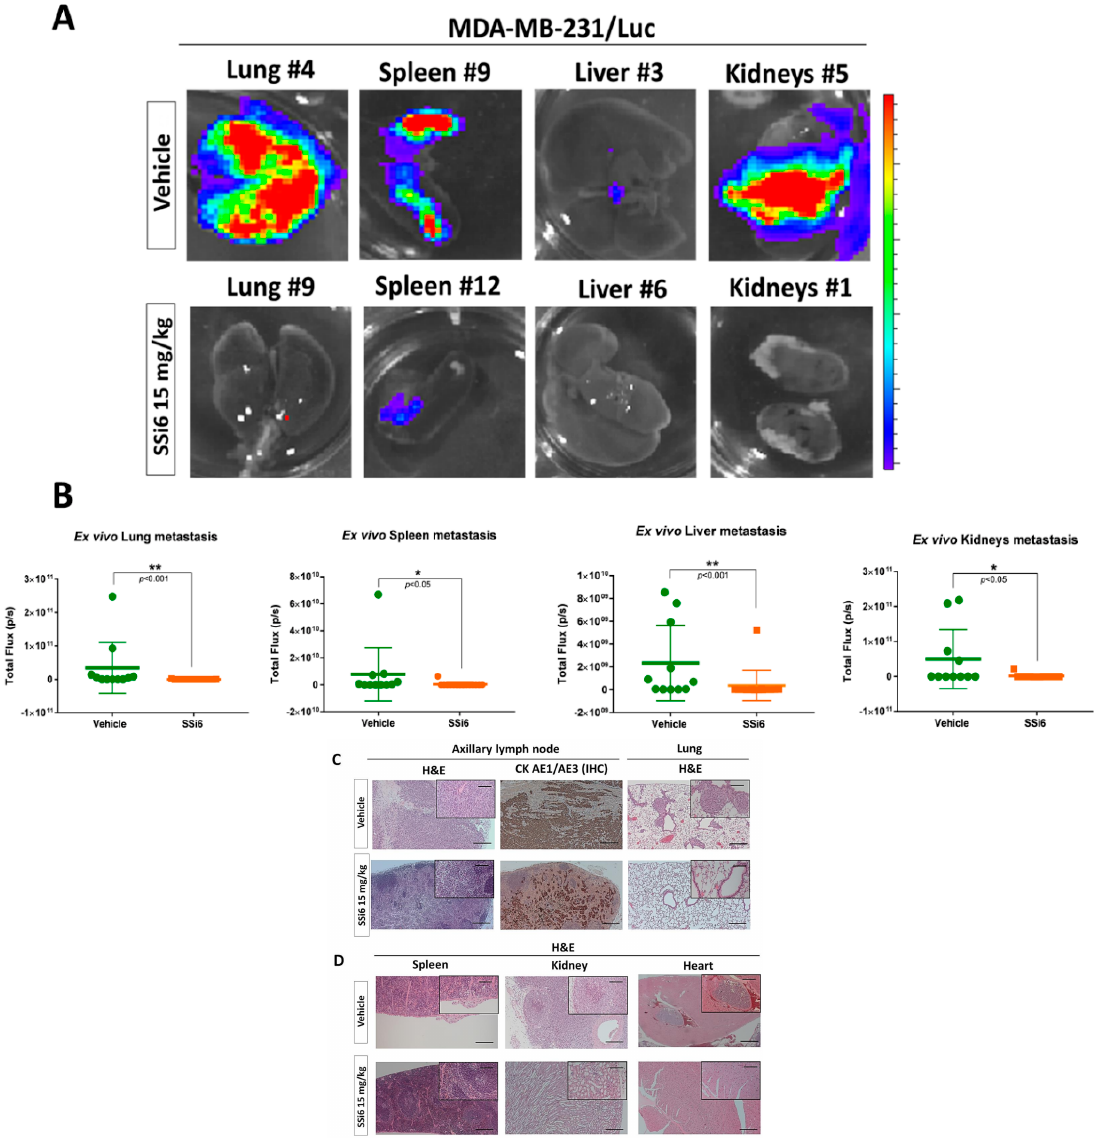
Figure 6. SSi6 interferes with multi-organ metastases and block the advancement of MDA-MB-231/Luc cells from lymph nodes to the lungs in a xenograft model with resection of the primary tumor. ( A ) Ex vivo bioluminescence images of the organs of the vehicle group (n = 11) and SSi6 15 mg/kg (n = 15). ( B ) Ex vivo graphs of the lung, spleen, liver, and kidneys, respectively. p -values were generated by Student’s t -tests (* p < 0.05, ** p < 0.001). ( C ) Micrograph of H&E staining and anti-human pan-cytokeratin IHC of harvested tissue to confirm the presence of breast cancer cell in the axillary lymph node. ( D ) Representative images of H&E stains showing metastatic nodules in the spleen, kidneys, and heart of the treated